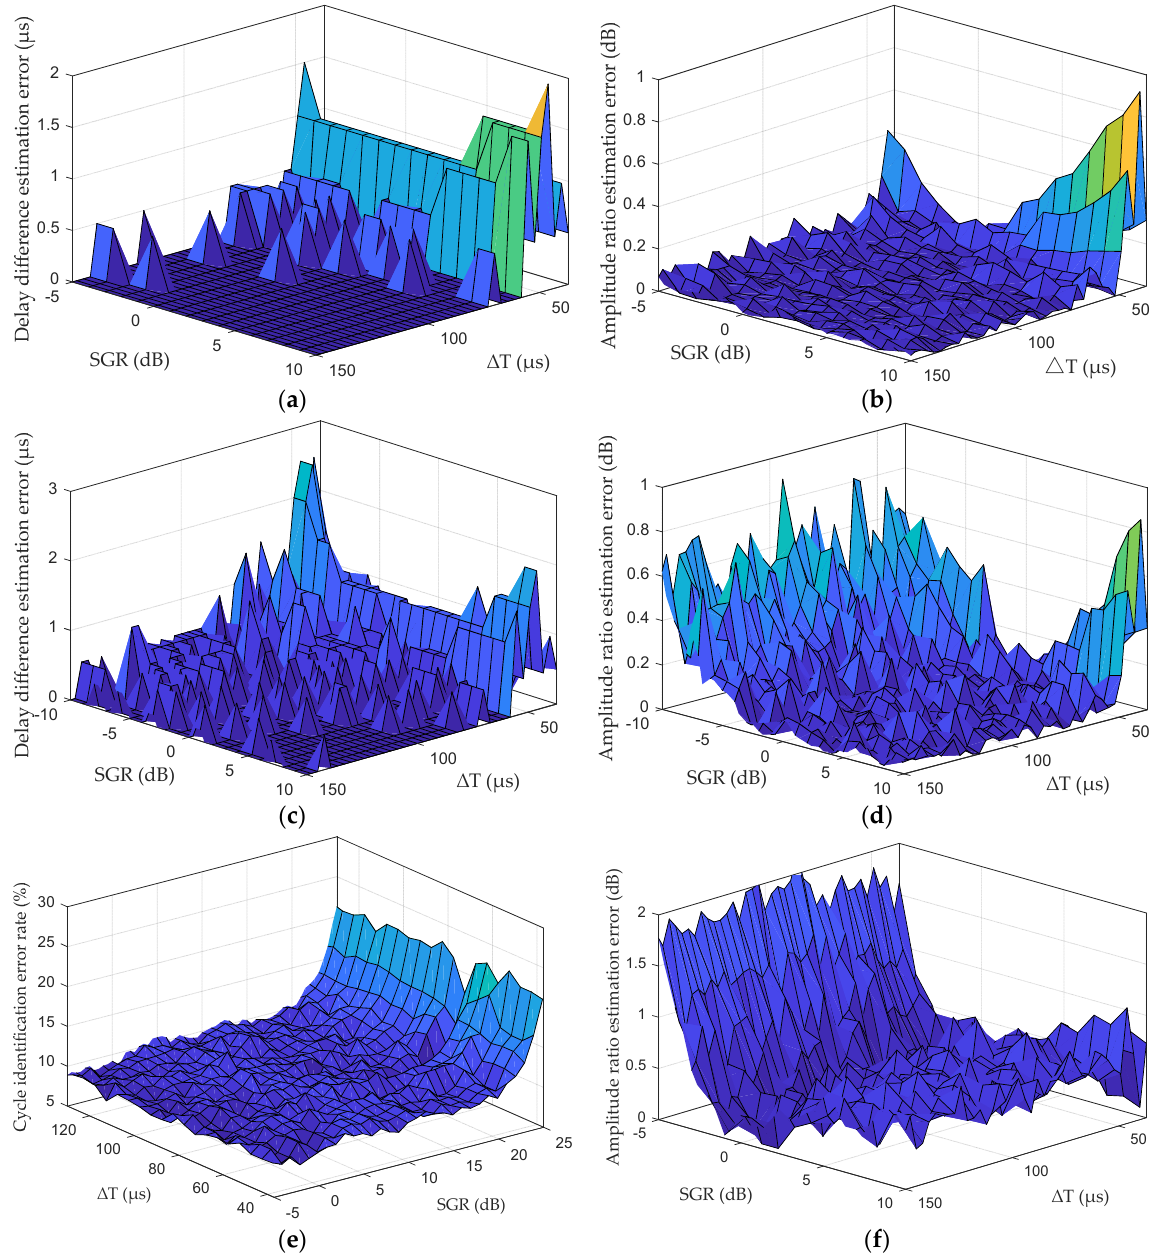
Figure 8. Performance simulation of spectrum-division method: ( a ) delay-difference estimation error at SNR = 5 dB; ( b ) amplitude-ratio estimation error at SNR = 5 dB; ( c ) delay-difference estimation error at SNR = 0 dB; ( d ) amplitude-ratio estimation error at SNR = 0 dB; ( e ) delay-difference estimation error at SNR = − 10 dB; ( f ) amplitude-ratio estimation error at SNR = − 10 dB.